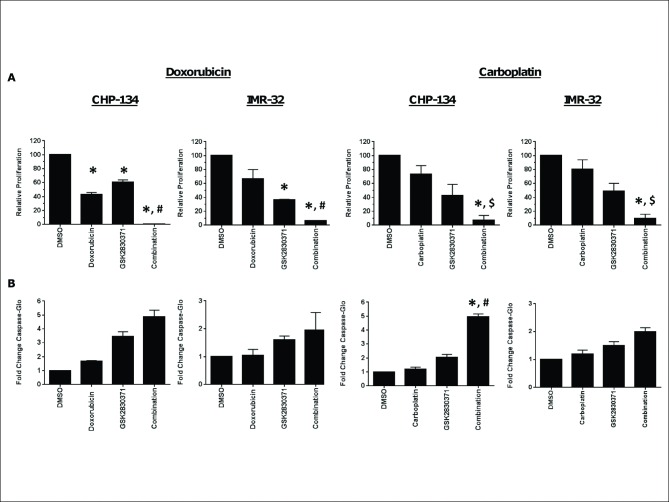
GSK2830371 has synergistic anti-proliferative activity with chemotherapeutic agents in neuroblastoma cells.CHP-134 and IMR-32 cells were exposed to 1 μM GSK2830371 for one hour prior to addition of doxorubicin (4 nM proliferation; 1 nM caspase) or carboplatin (1 μM proliferation; 10 μM caspase). CellTiter-Glo (A) was added to plates at 72 hours and caspase-Glo 3/7 (B) was added to separate duplicate plates at 24 or 48 hours post-drug addition. Data represent mean ± SD. *p<0.05 vs DMSO control, #p<0.05 vs both single agents, $p<0.05 vs doxorubicin or carboplatin alone, using t-test, (2 tailed, unequal variance).